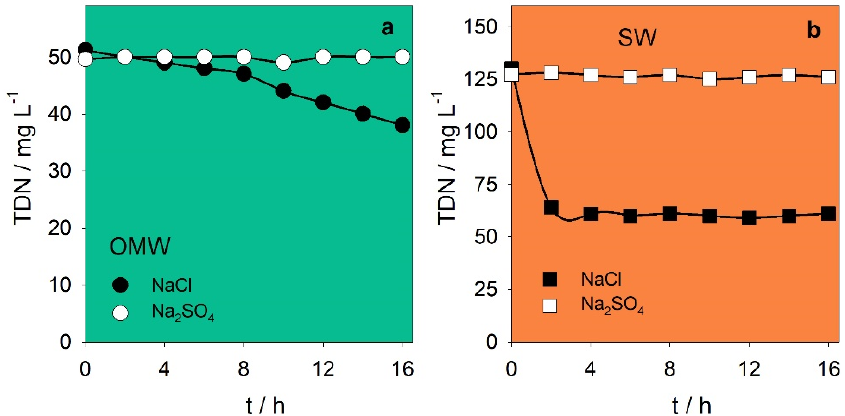
Figure 3. Total dissolved nitrogen (TDN) variation along the electrooxidation treatment of ( a ) Olive mill wastewater (OMW) and ( b ) Slaughterhouse wastewater (SW), utilizing NaCl or Na 2 SO 4 as supporting electrolyte.